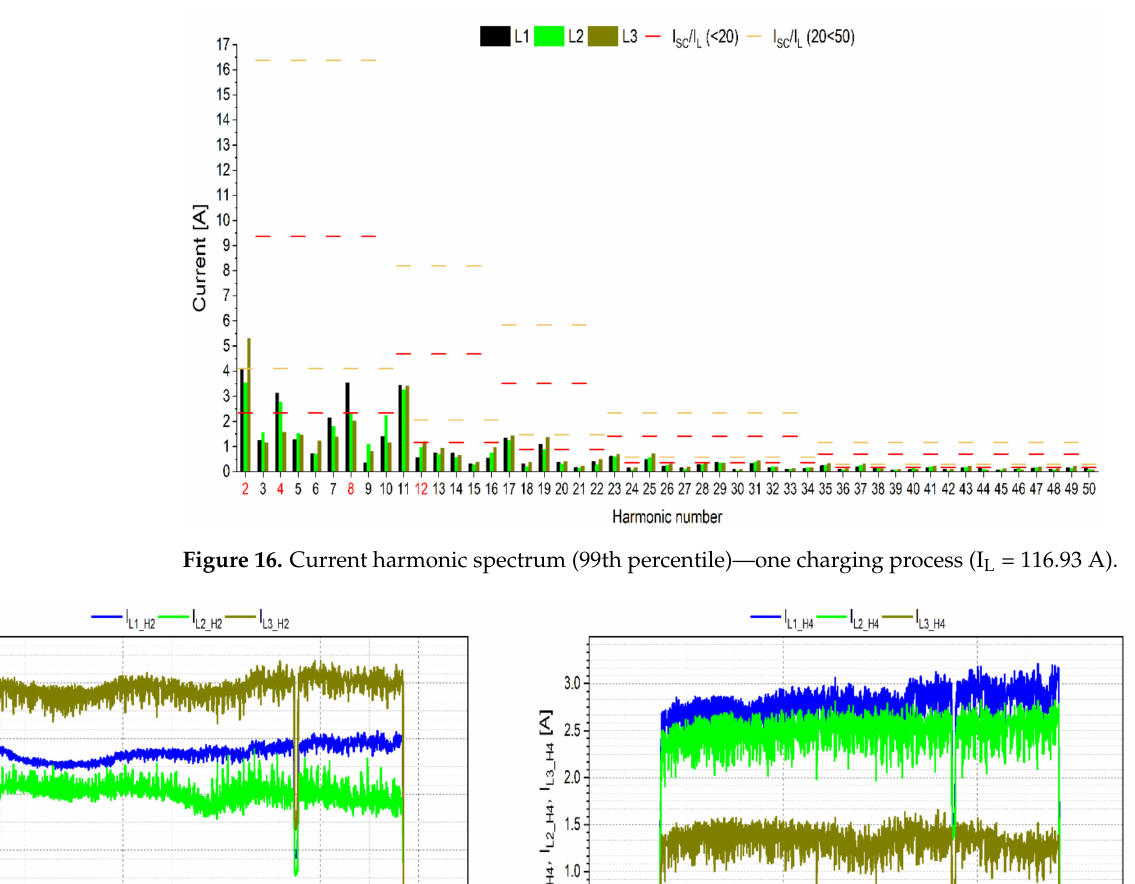
Figure 15. Current harmonic spectrum (95th percentile)—one-week measurement period (I L = 1068.57 A).